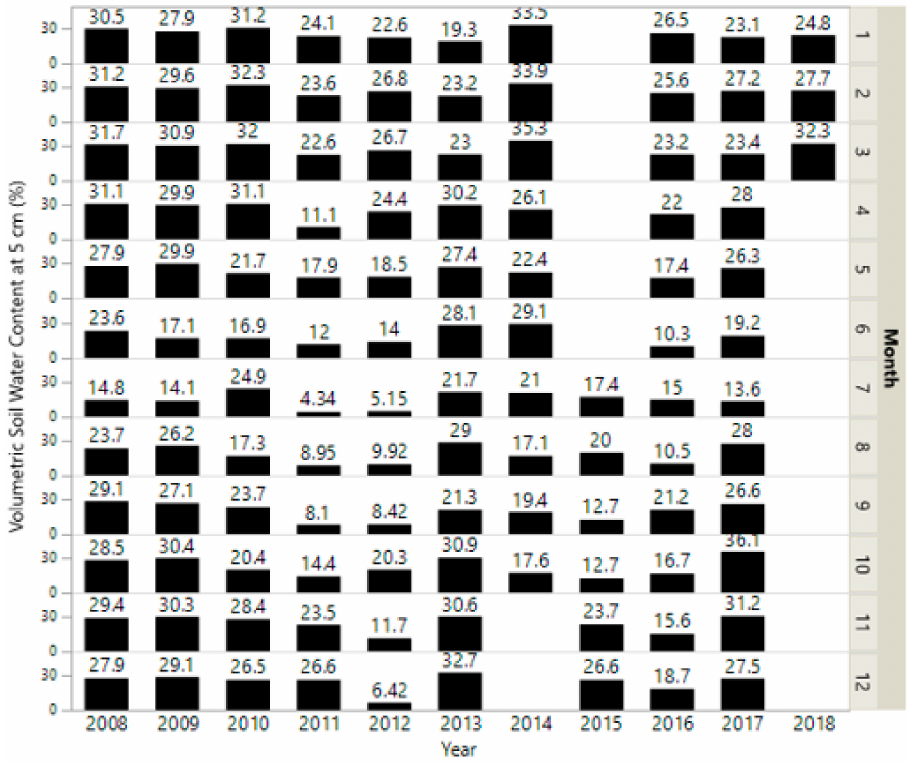
Figure A2. Monthly average volumetric water content (%) at 5 cm depth by